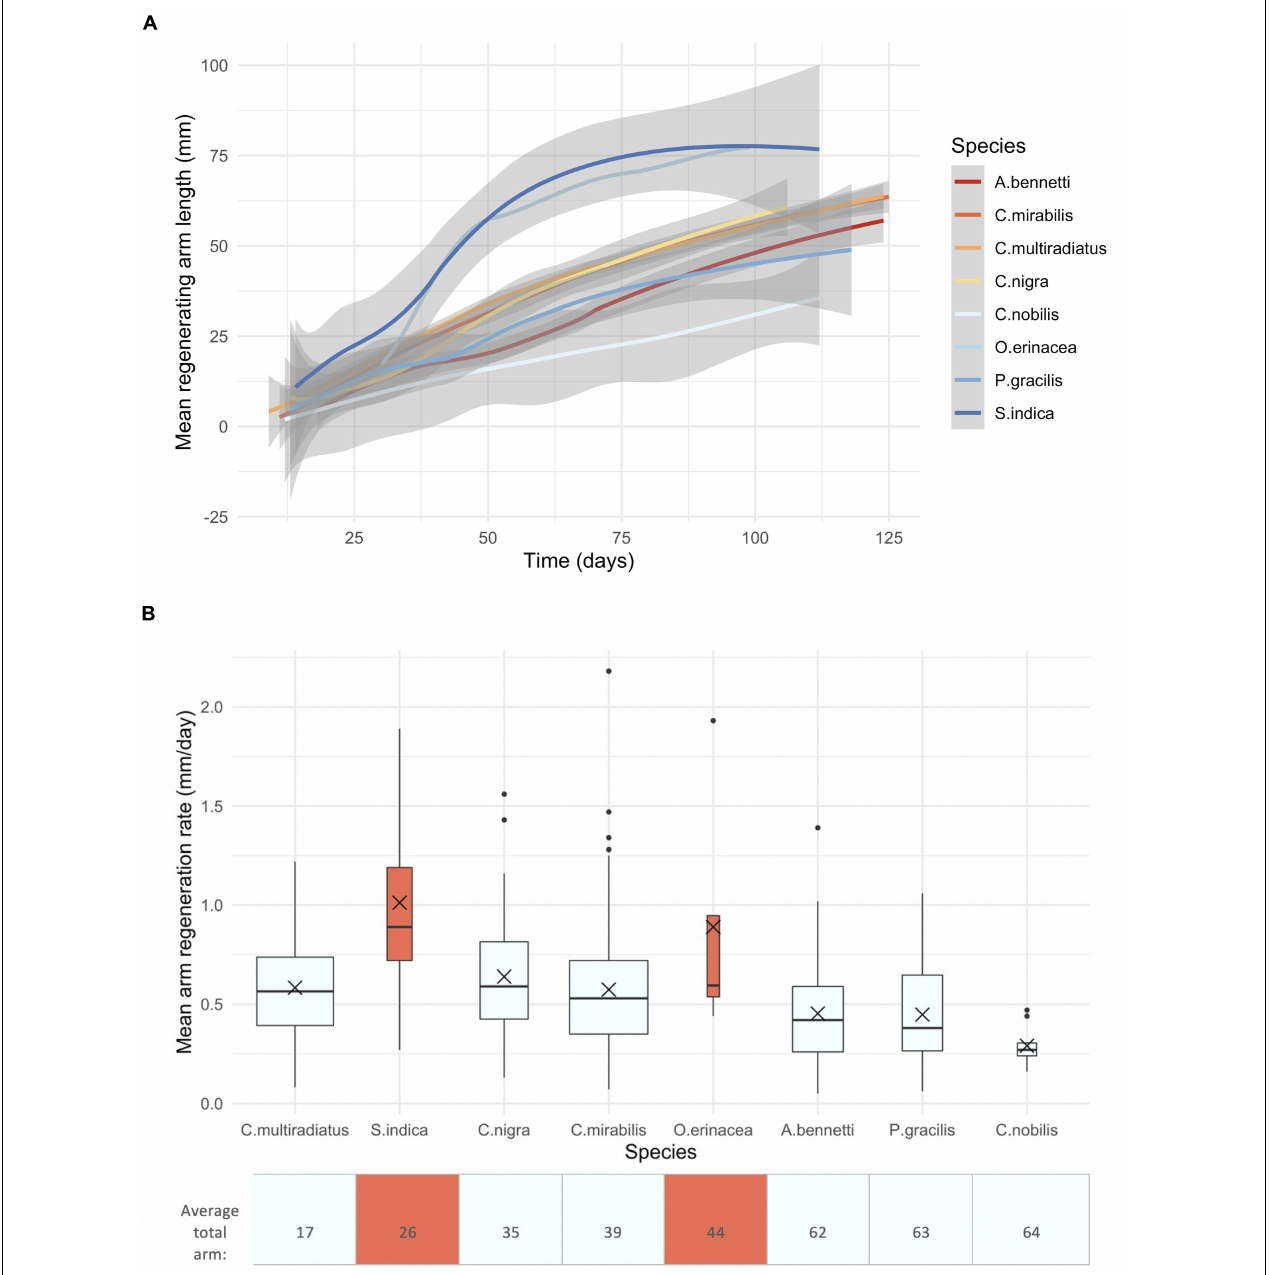
FIGURE 3 | Arm length over time (A) and mean regeneration rates of eight tropical feather stars (B) : six non-swimming [blue in (B) ] family Comatulidae ( Anneissia bennetti, Capillaster multiradiatus, Clarkcomanthus mirabilis, Comaster nobilis, Comatella nigra, Phanogenia gracilis), and two swimming [red in (B) ] family Mariametridae ( Oxymetra cf. erinacea, Stephanometra indica) . (A) The 95% confidence interval of each curve is shown. (B) Species are ordered by average arm number, increasing from left to right. Box and whiskers show the median as a line, first and third quartiles as hinges, and the highest and lowest values within 1.5 times the inter-quartile range as whiskers. X = mean. Generated from 535 independent segments on 123 adult feather stars. Boxplot width scaled with sample